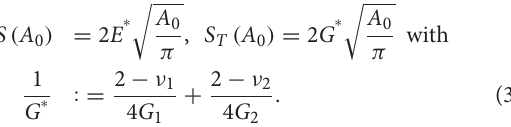
agreement of the friction force and the friction